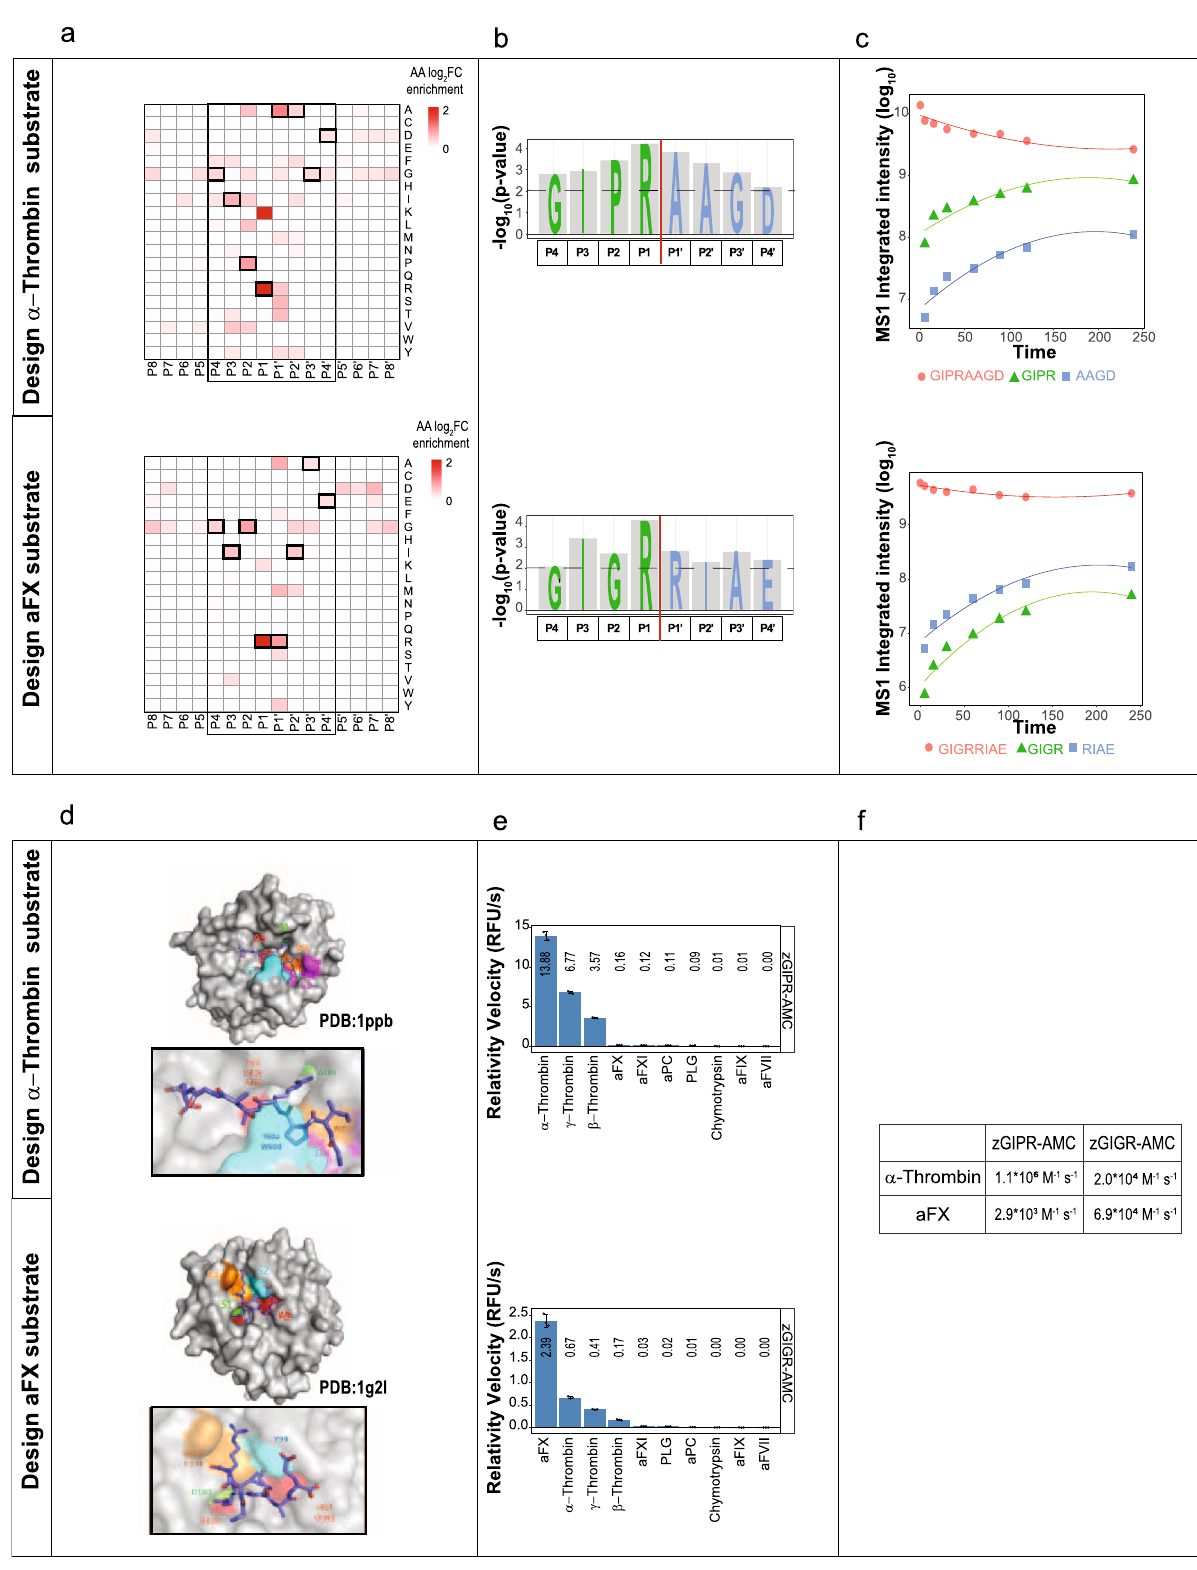
these peptides were cleaved effectively by the respective proteases. We monitored the intensity of the cleavage products by mass spectrometry, using MS1 signal integration (Fig. 5c). The results showed the expected patterns and thus con fi rmed that both synthetic peptides represent a good entry point for development of